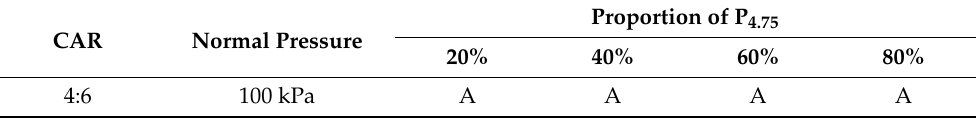
Table 7. Experimental design of particle diameter against shear